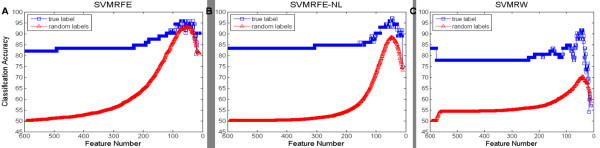
Trends of Prediction Performance over Multimode Dataset and Random Datasets Generated over Permutation Test during Iterative Feature Selection Methods. Comparison between the trend of the prediction performance of the multimode dataset (in blue square) and that of the averaged prediction performance of the datasets with random label permutations (in red square) to the number of remaining features during iterative feature selection methods (A) SVMRFE, (B) SVMRFE_NL, and (C) SVMRW. The x-axis is the number of remaining features, and the y-axis is prediction performance (measured by the LOOCV average accuracy).